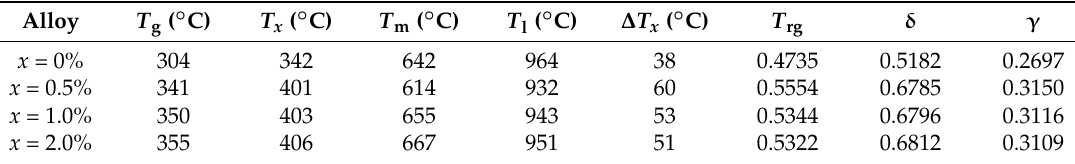
Table 1. Thermodynamic parameters of the TA–Si x filler